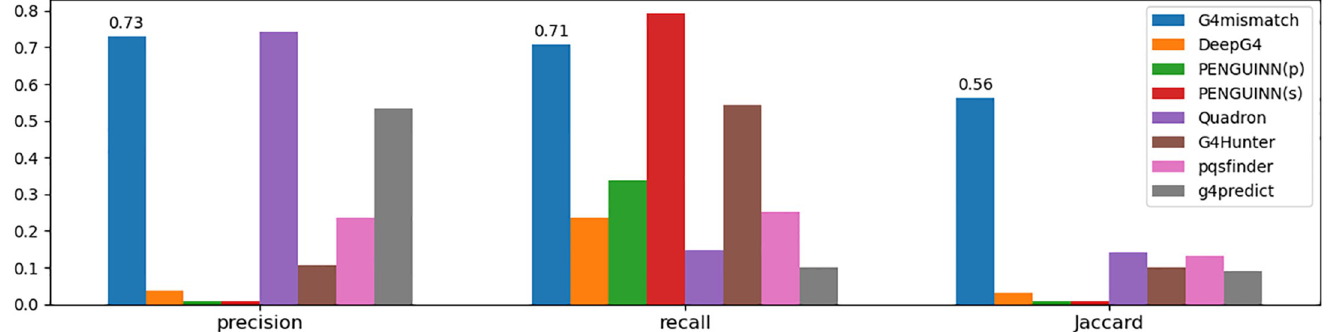
Fig 5. G4mismatch and extant methods performance in K + -stabilized G4 detection. G4mismatch has consistent superior performance as evaluated by precision, recall, and Jaccard scores, achieving high recall without compromising precision.